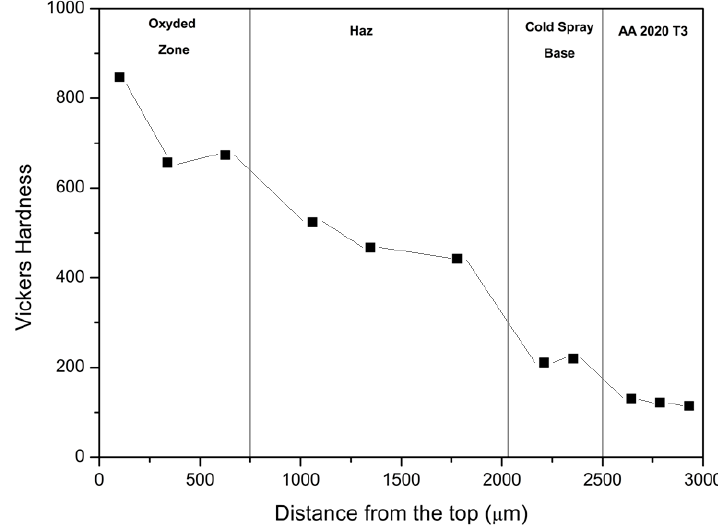
Figure 4. Microhardness measurements taken through the plate cross ‐ section.